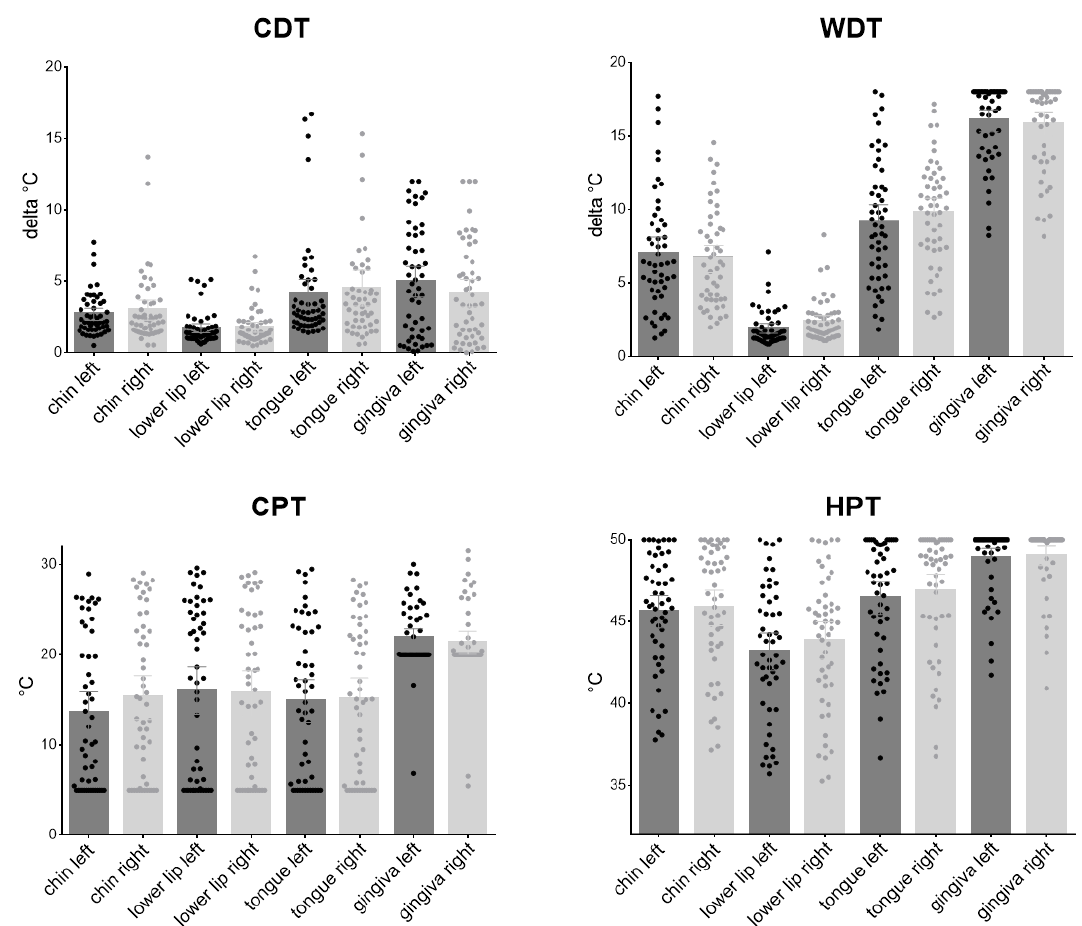
Figure 2. Thermal thresholds (detection and pain raw values) for extraoral (chin, lower lip) and intraoral (tongue tip, gingiva) left and right areas. (CDT = Cold Detection Threshold, CPT = Cold Pain Threshold, WDT = Warm Detection Threshold, HPT = Heat Pain Threshold).